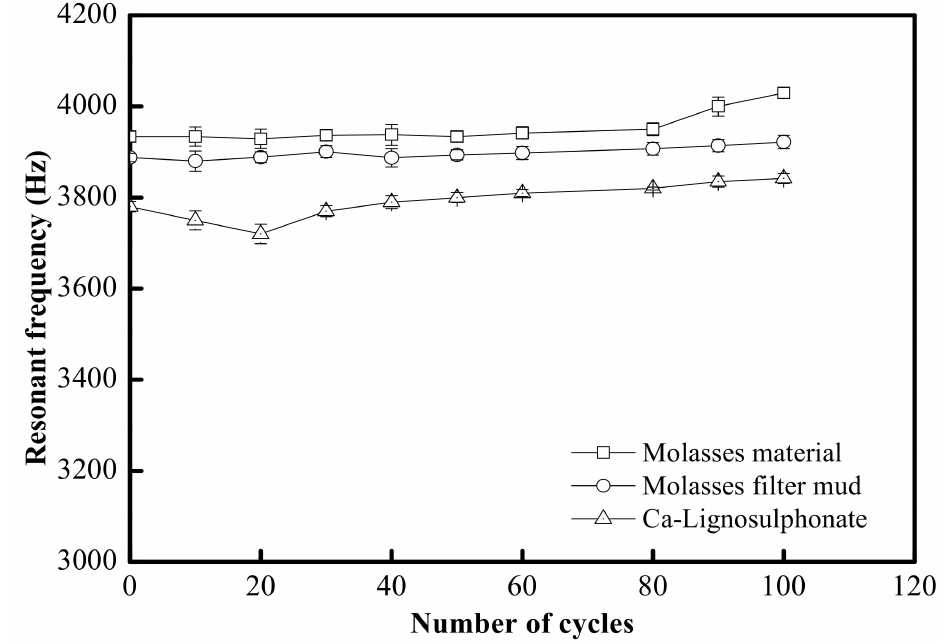
Figure 5. Variation of resonant frequency with freezing–thawing